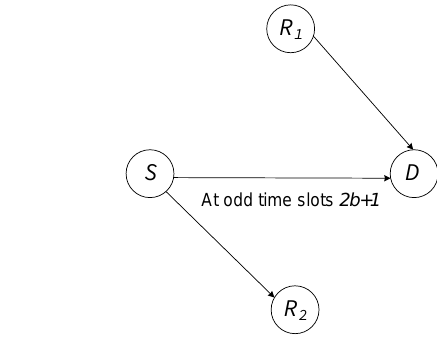
Figure 1. The TPSR system under